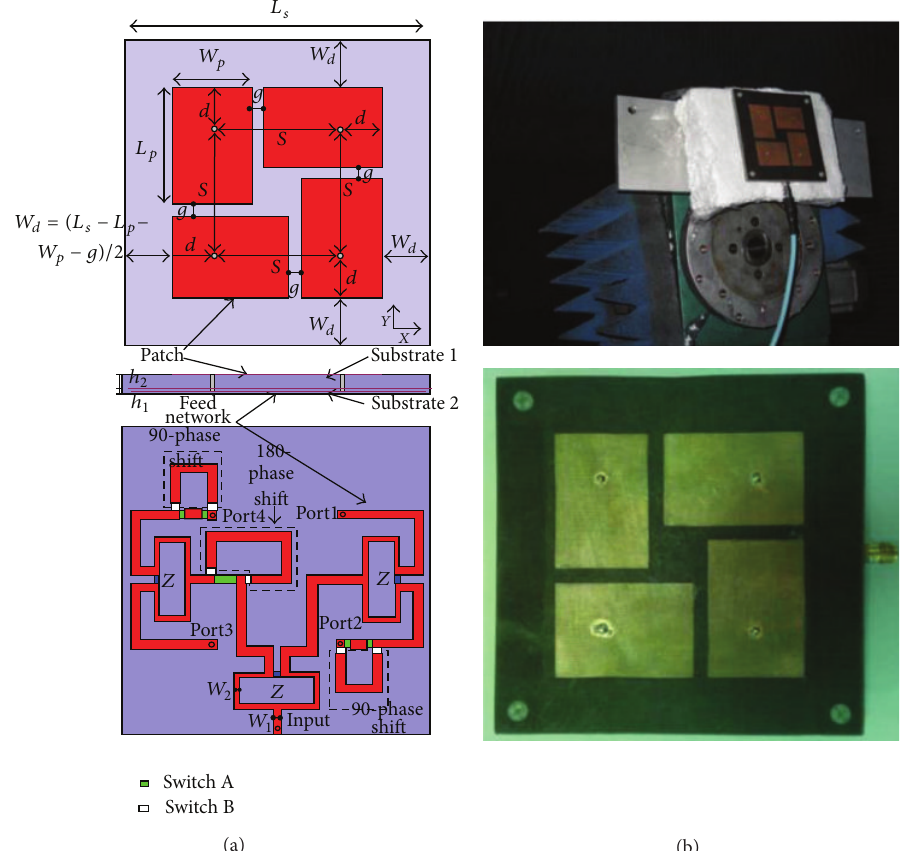
Figure 11: (a) The pattern and polarization reconfigurable microstrip antenna. (top) Top view. (middle) Side view. (bottom) Bottom view. (b) Measurement setup photograph and the fabricated antenna (with permission from